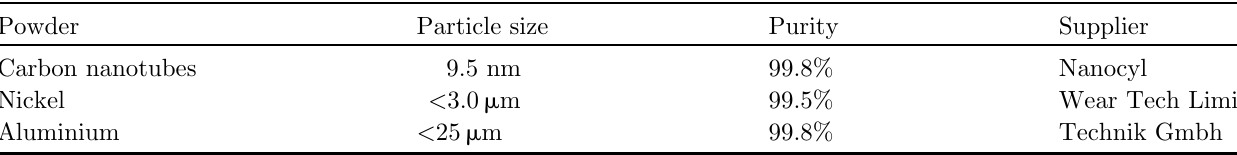
Table 1. The starting materials used for the